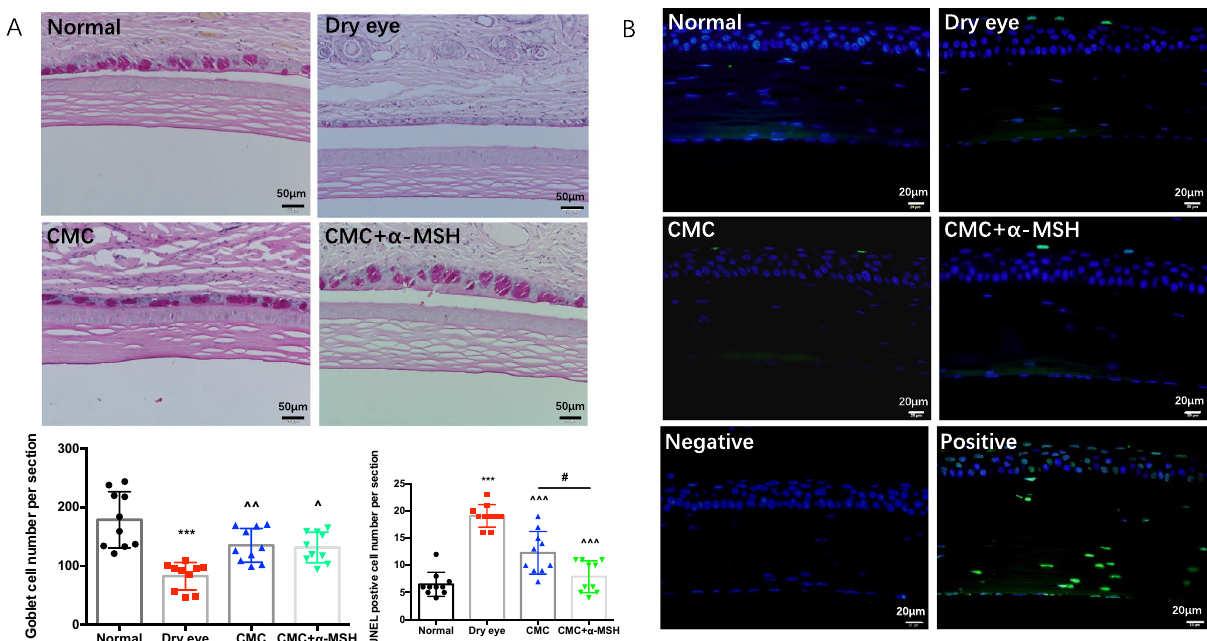
Figure 2. Combined CMC + α-MSH treatment enhanced the number and size of conjunctival goblet cells and reduced the number of apoptotic cells in cornea. Rats were divided into normal, dry eye, CMC, and CMC + α-MSH groups. The number and size of conjunctival goblet cells were examined by PAS staining. Representative images of PAS staining are shown. The number of conjunctival goblet cells was quantified ( A ). The number of apoptotic cells was examined by TUNEL staining. Representative images of TUNEL staining are shown. The number of apoptotic cells was quantified ( B ). Data are shown as mean ± SEM, n = 10 per group. *, comparison of dry eye group and normal group; ^, comparison of CMC treatment group or combined CMC + α-MSH treatment group and hypertonic group; #, comparison of CMC treatment group and combined CMC + α-MSH treatment group; ns, not significant. *, ^, # p < 0.05; **, ^^ p < 0.01; ***, ^^^ p <